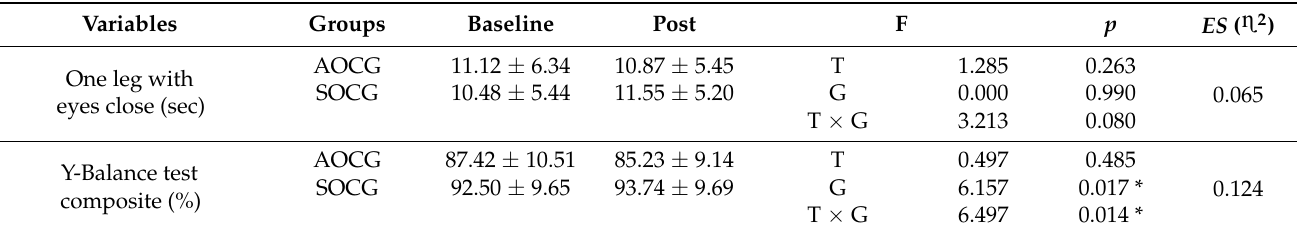
Table 4. Changes in balance. Table 1. Changes in body